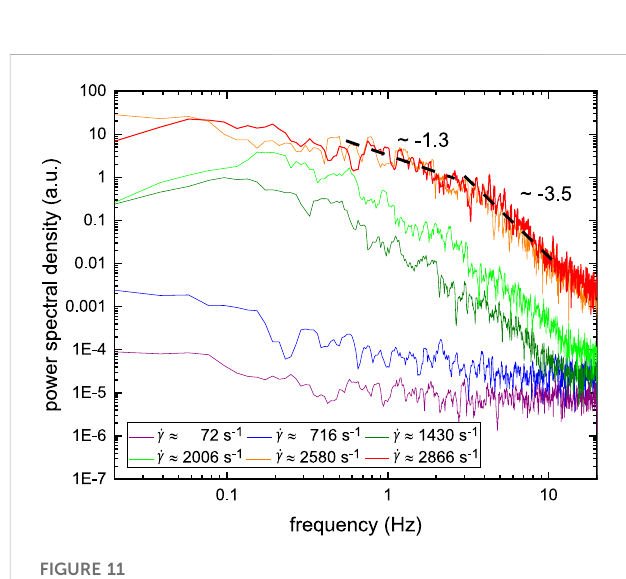
Figure 10C, we observed a fully laminar fl ow, in which the path lines follow the curvature of the serpentine channels. At _ γ ≈ 1146 s − 1 in